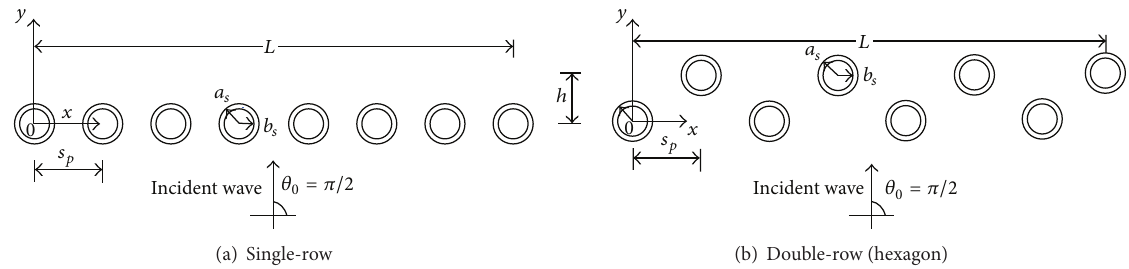
Figure 2: The reference system and analysis model of incident plane waves scattering by rows of piles ( 𝑁 = 8 ).